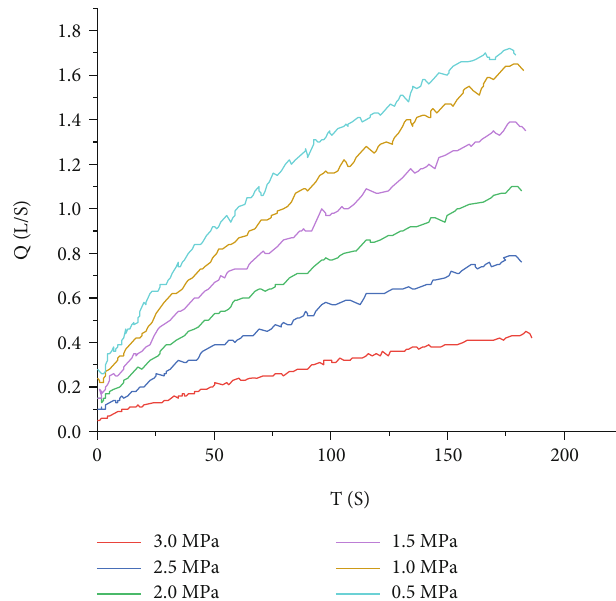
Figure 5: Relationship between the gas emission and gas pressure in the borehole.